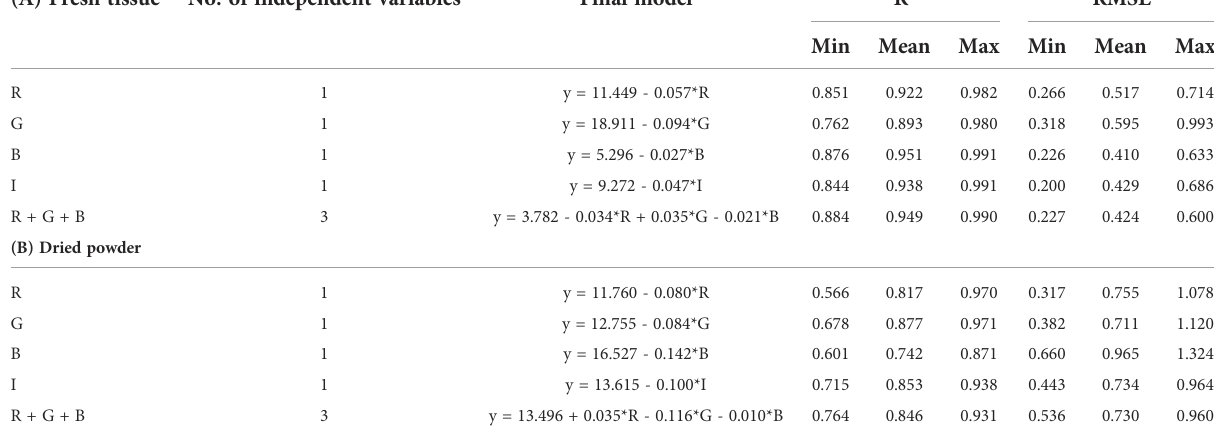
TABLE 2 Tenfold cross validation of the different models for (A) fresh tissue, and (B) dried powder of Ulva fenestrata . (A) Fresh